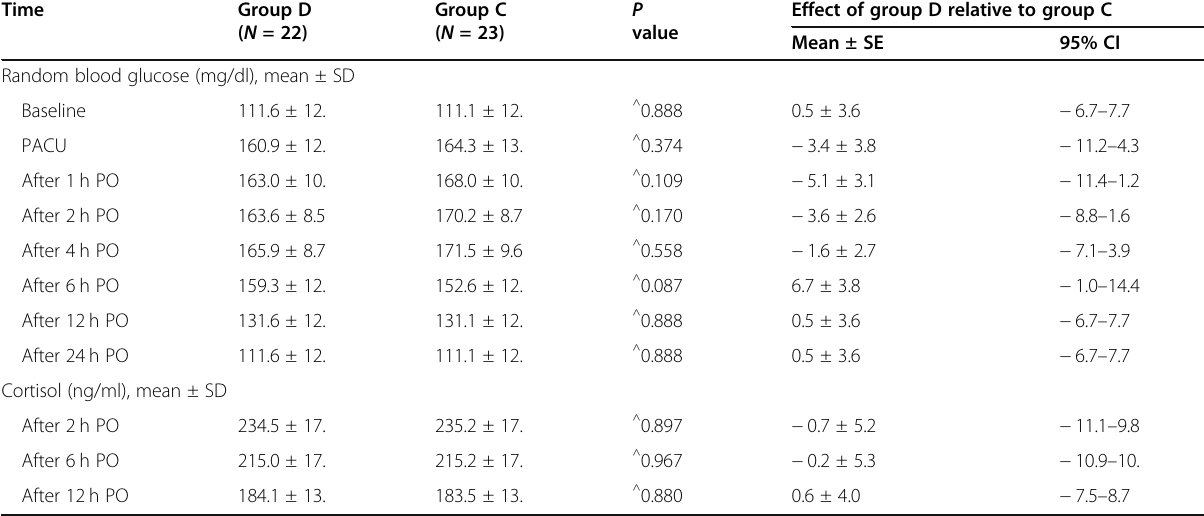
Table 4 Comparison between group C and group D according to RBS and cortisol level Time